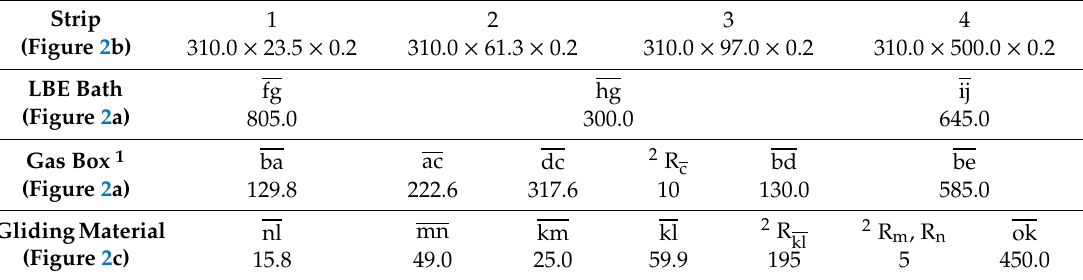
Figure 2. Computational domains, dimensions are found in Table 1: ( a ) Three-dimensional solution domains, ( b ) stainless steel strip, ( c ) gliding material. Table 1. Dimensions of computational domains (mm). The distances are defined in Figure 2.